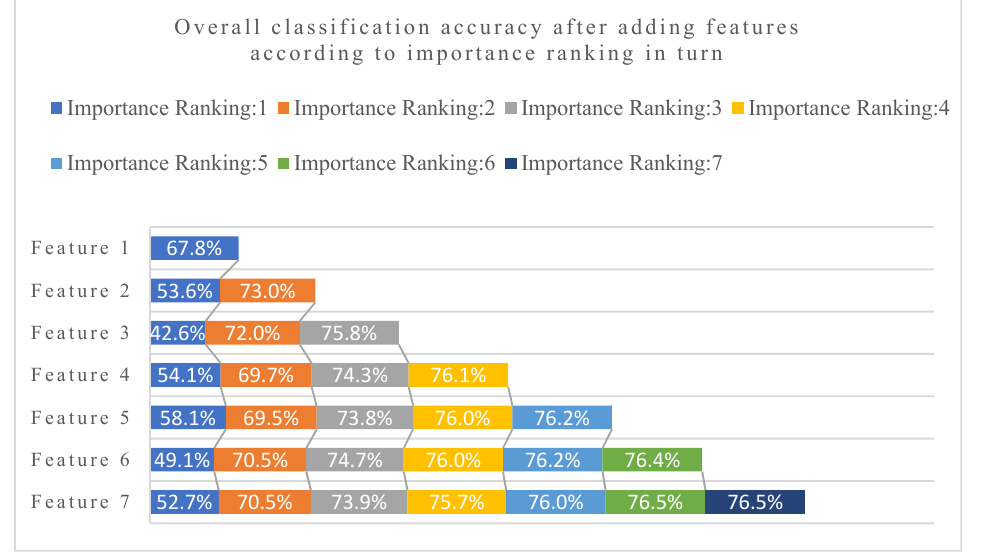
Figure 11. Detailed data for each round of feature selection in the A3 region.